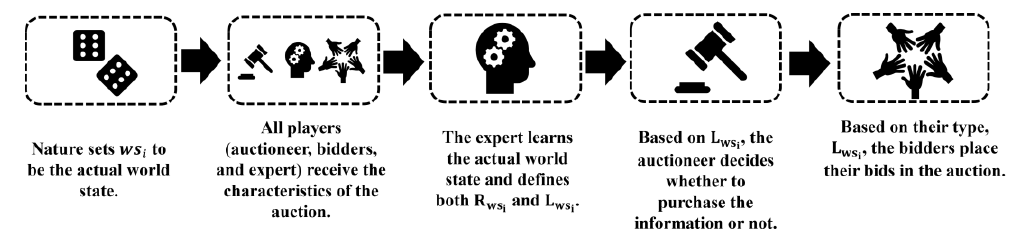
Figure 1. Flowchart of the model.